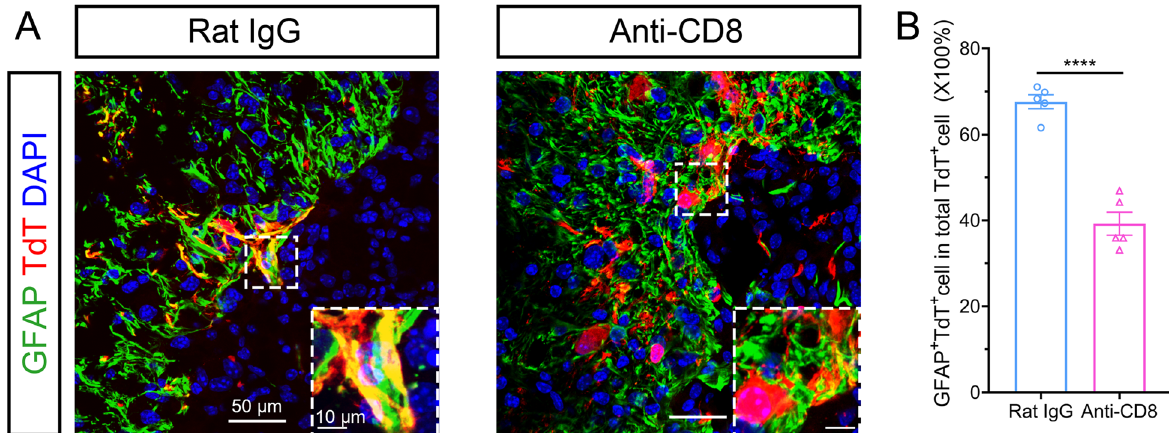
Fig. 7 CD8 + T cells promoted NSCs to differentiate into astrocytes in vivo. A Immunofluorescence staining showing the percentage of GFAP + astrocytes differentiated from NSCs in lineage tracing mice (Nestin‑CreERT2::Ai9 mice) after the administration of an anti‑CD8 antibody at 14 dpi. Equal rat IgG was used for control. Scale bar, 50 μm or 10 μm. B A statistical graph of A , n